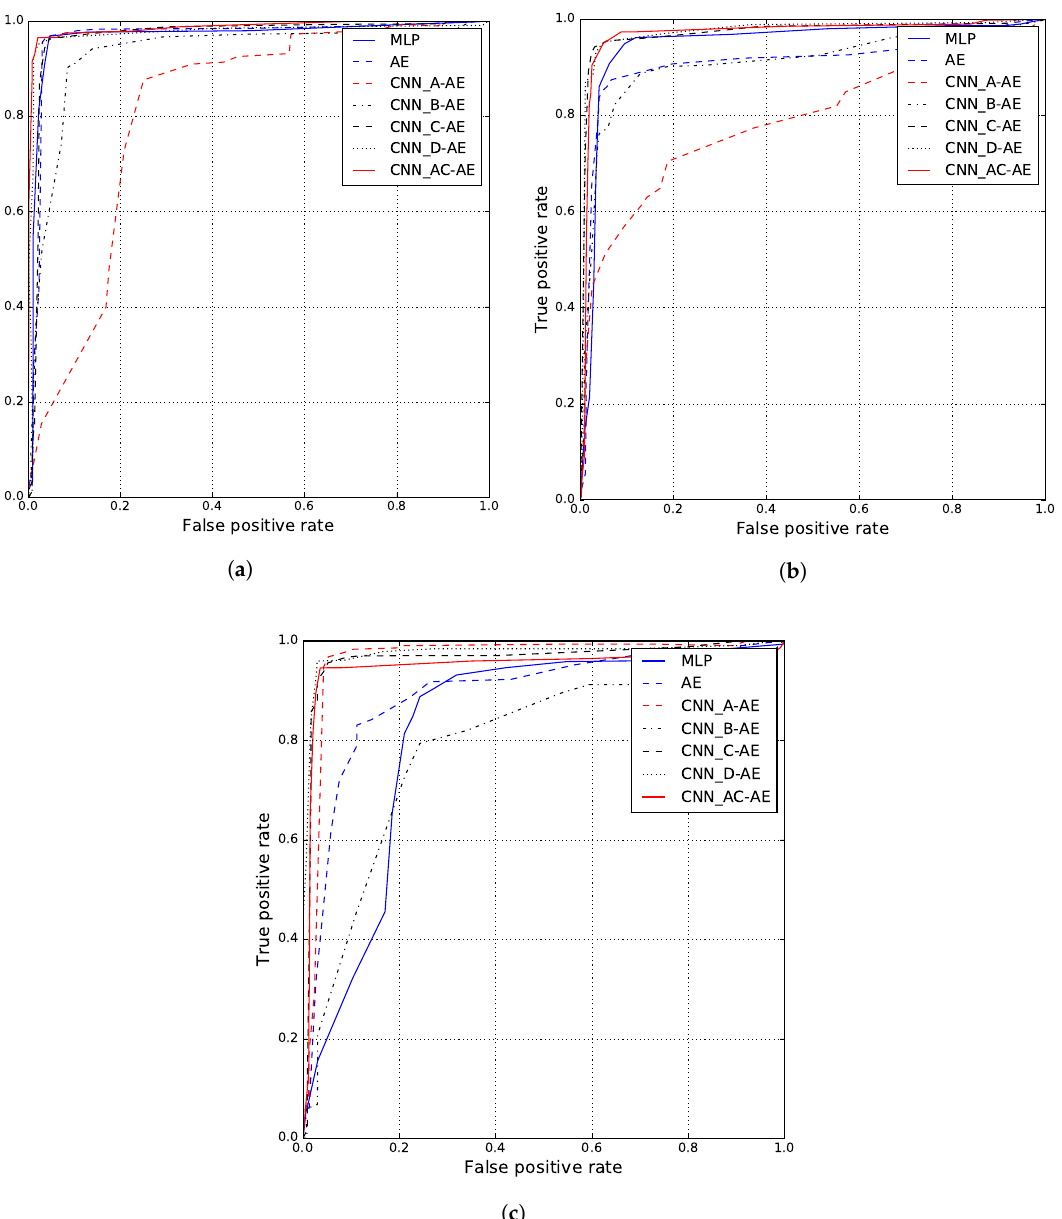
Figure 8. ROC curve of: ( a ) subject/others; ( b ) time difference; and ( c ) skilled